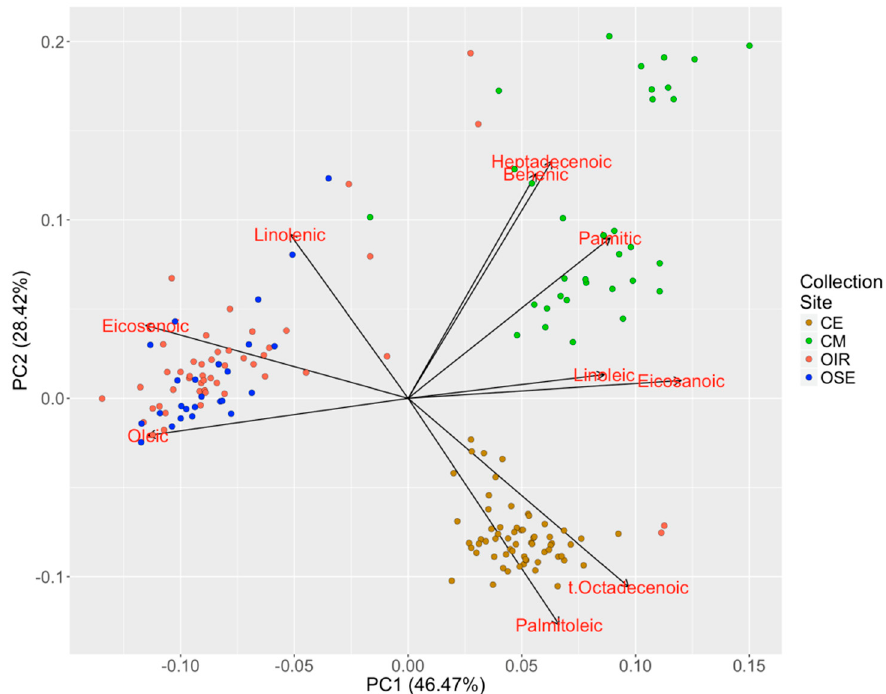
Figure 3. Biplot of the first two principal components (PCs) calculated on the fatty acid dataset. The scaled values of the loadings calculated on the basis of the original variables are shown in red.